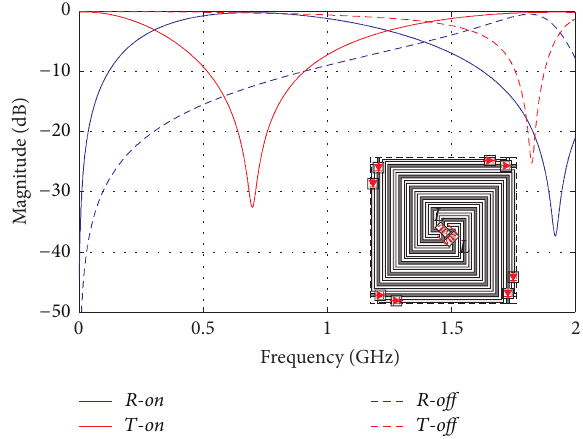
Figure 12: Transmittance and reflectance at normal incidence of the AFSS with the unit cell of Figure 8, with four additional pin diode switches introducing the spiral arms, in the on (solid lines) and off (dashed lines) states.